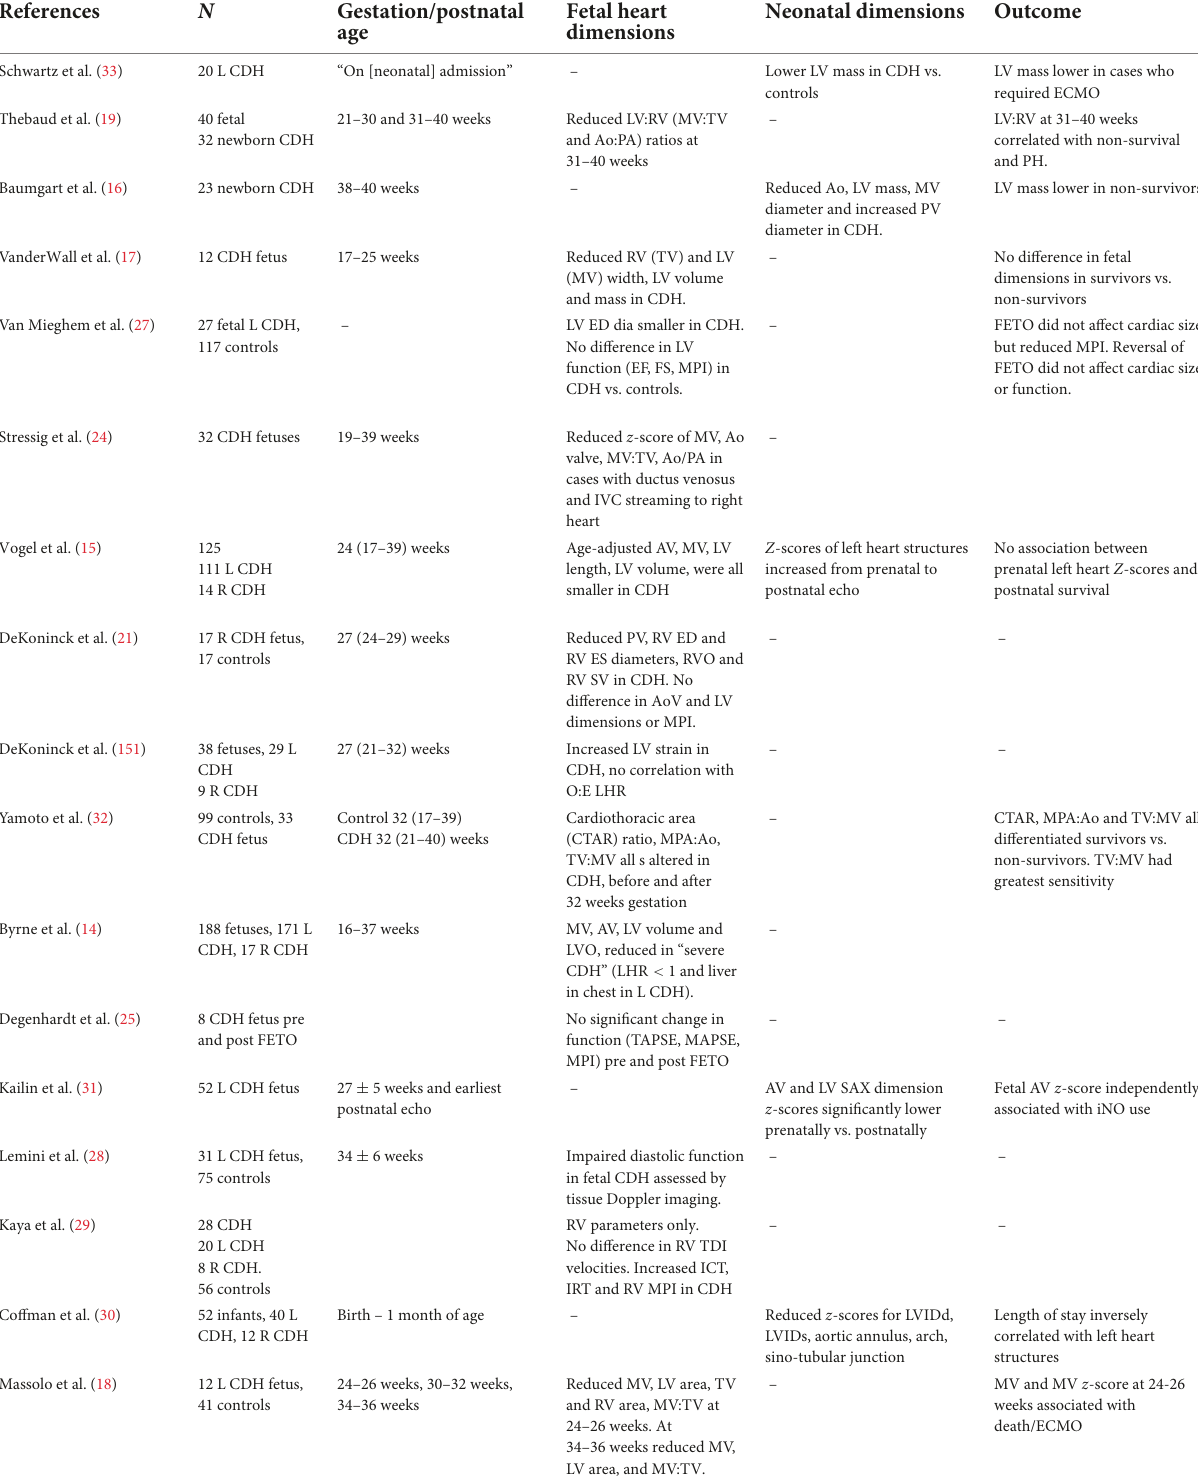
TABLE 1 Echocardiographic studies of fetal and early postnatal cardiac dimensions and fetal cardiac function in